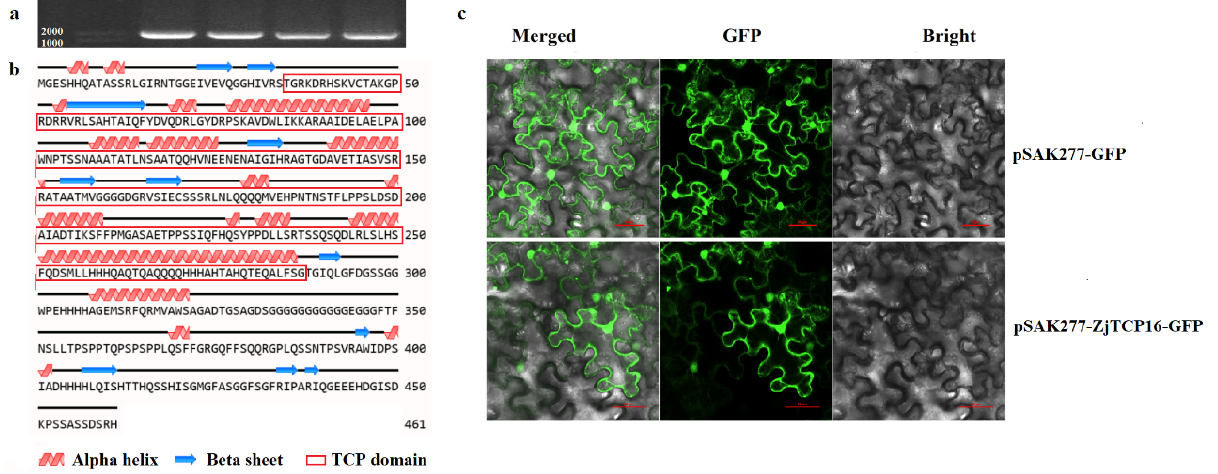
Figure 1. Characterization of ZjTCP16. ( a ): The PCR-amplified products using ZjTCP16 -specific primers were separated by gel electrophoresis. The lane from left to right is DL2000 DNA Marker and four replicates of ZjTCP16 gene amplification. ( b ): Predicted secondary structure of ZjTCP16. The TCP domain is outlined with a box and is predicted to bind to DNA and interact with proteins. ( c ): Subcellular localization of ZjTCP16-GFP fusion protein.